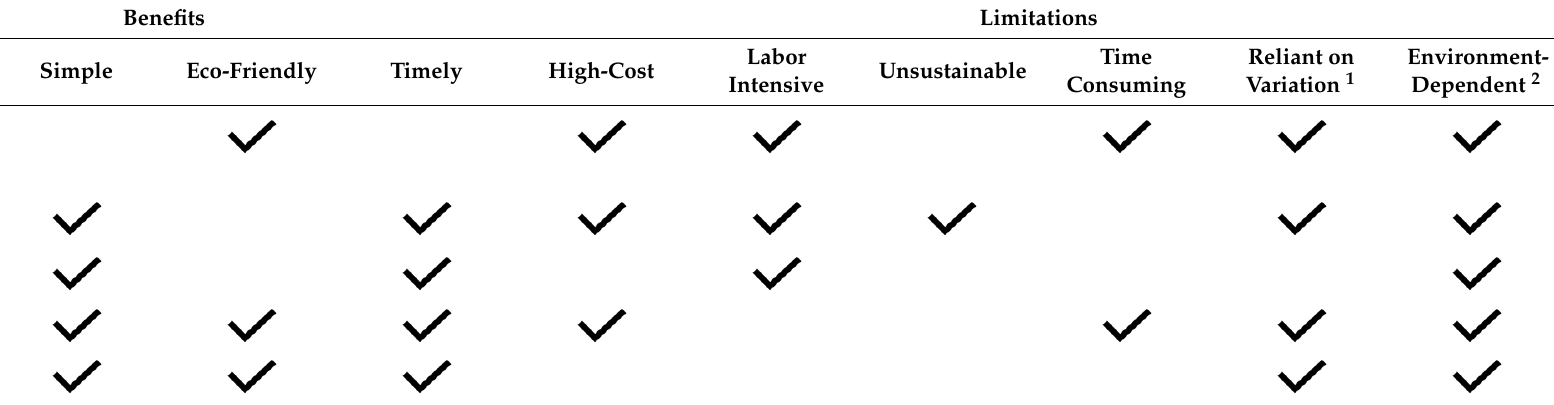
Table 1. Benefits and limitations of conventional breeding and agronomic biofortification approaches.